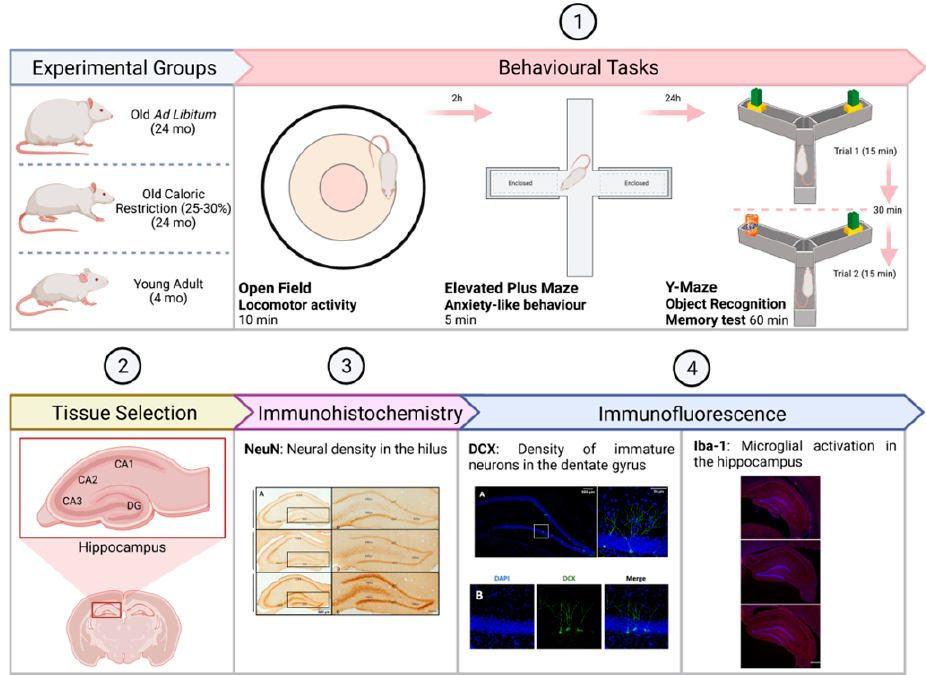
Figure 1. Overview of the experimental design (created with BioRender.com). OLD AL: Old AdLib- itum group; OLD CR: Old Caloric Restriction group; YA: Young Adult group; EPM: elevated plus maze; OF: Open field; SOR: spatial object-recognition.